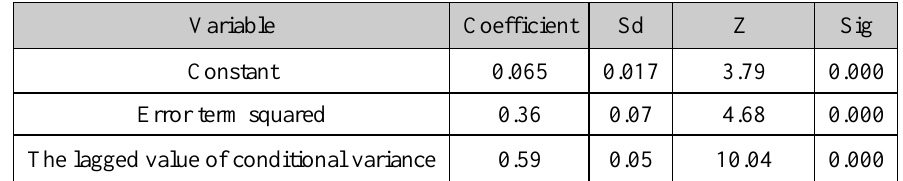
Table 3: variance model